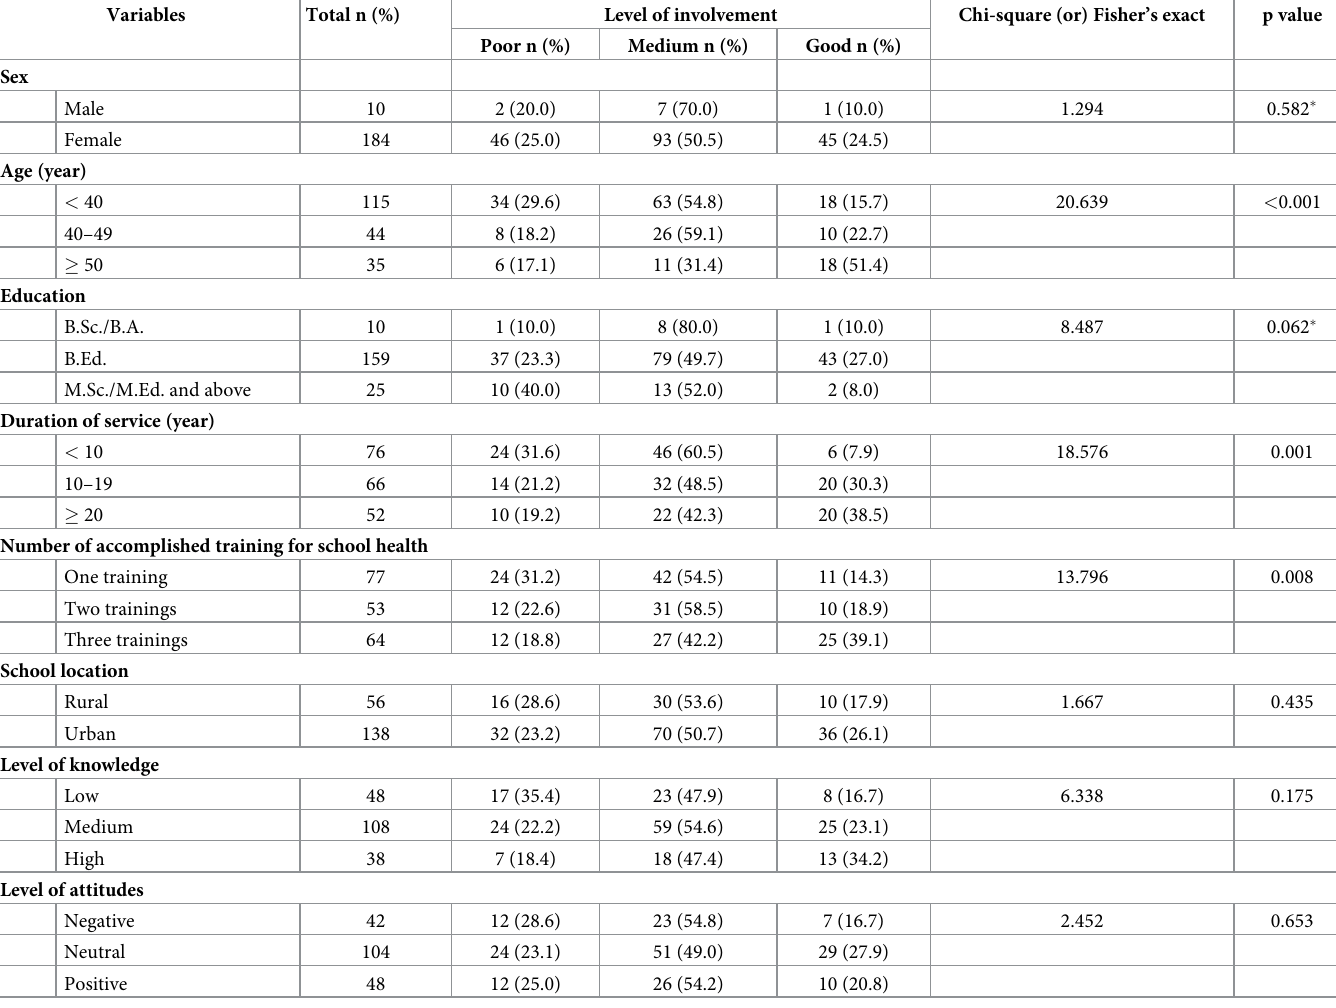
Table 3. Factors associated with level of involvement in Health Promoting School activities among high school